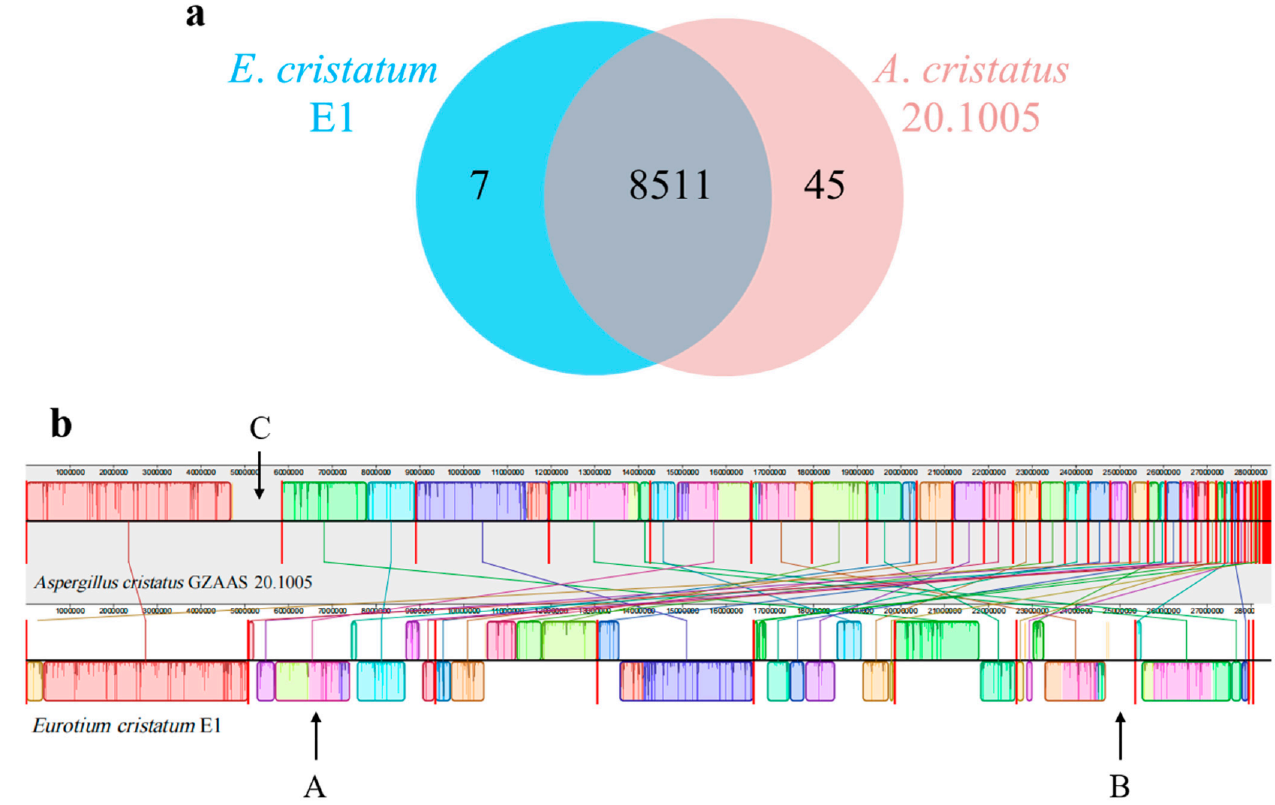
Figure 3. Comparative analysis of Eurotium cristatum E1 and Aspergillus cristatus GZAAS 20.1005. ( a ) Venn diagram illustrating the overlap of shared (core) and strain-specific (accessory) protein coding genes in the genomes of E . cristatum E1 and A . cristatus GZAAS 20.1005. ( b ) Each contiguously colored box is a locally collinear block (LCB), represent homologous regions with another genome without rearrangement. Lines between two genomes trace each orthologous LCB through every genome. LCBs below a genome’s center line are in the reverse complement orientation relative to the reference genome. The bold red lines represent the boundary of